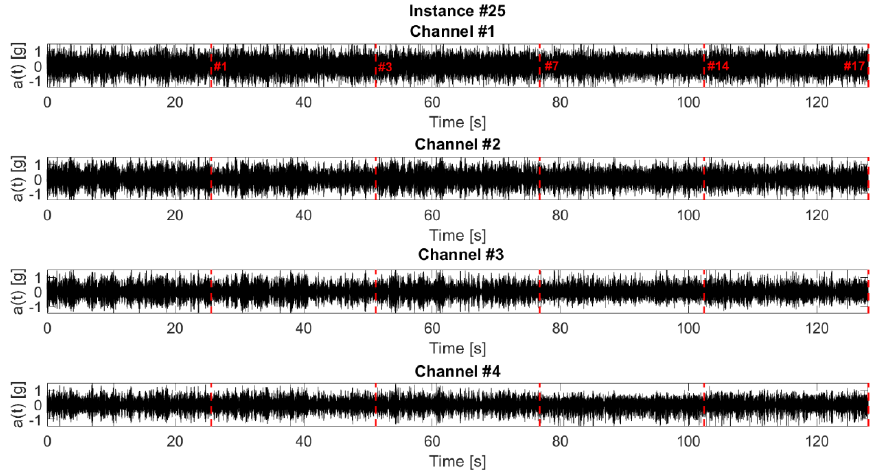
Figure 4. The concatenated signals for the four output channels (25th instance). The transition time from one state to the next one is indicated by the dashed red lines.